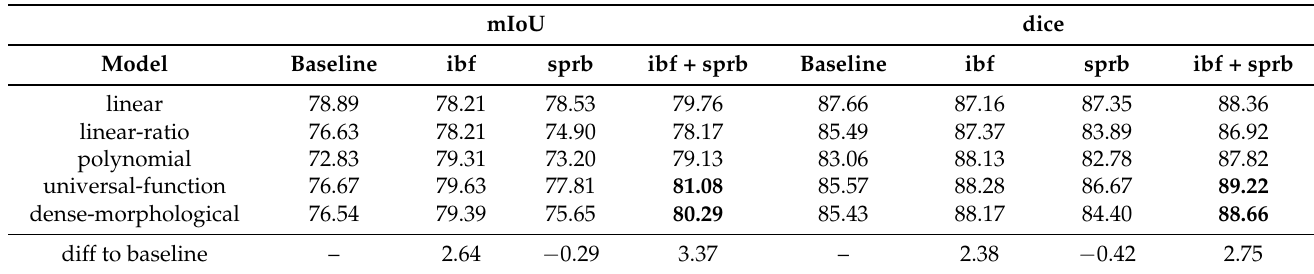
Table 4. Scores of DeepIndices with/without ibf and sprb for a kernel size of 3. mIoU